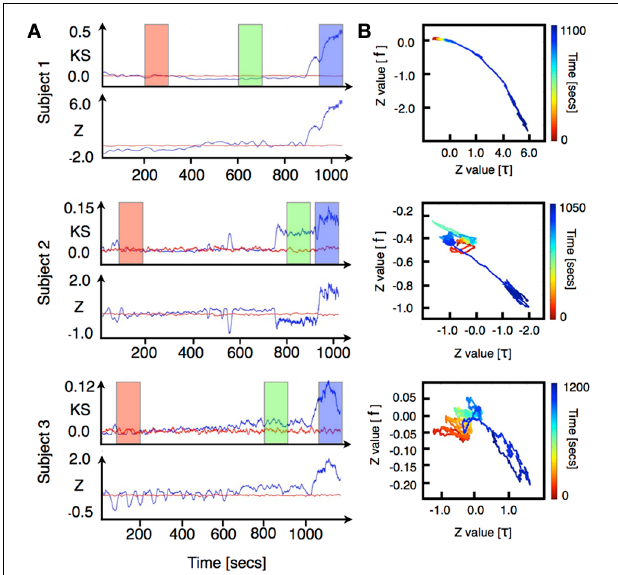
FIGURE 1 | ECoG signals were recorded from three human subjects as they were induced into general anesthesia. Data was locally fitted with VAR(1) models in windows of 200ms every 100ms (see methods). The linear stability of each model is compared to the awake state by means of two statistical tests. (A) top rows: Kolmogorov Smirnov test. For each model we plot the KS statistics of comparing the fitted distribution of eigenvalues against the awake state. (A) bottom rows: The distribution of time scales is compared using Wilcoxon test. Both quantities were averaged in time intervals of 10 s. The stability properties of locally fitted VAR(1) models change as the subjects undergo anesthesia. We defined three different segments (color rectangles) which were used for subsequent figures. (B) Changes in the frequency and stability of the eigenmodes. We compared the distributions of frequencies and time scales using a Wilcoxon test. In each figure, the vertical axis shows the z -value of comparing the frequency distributions whereas the horizontal axis shows the same test for the stability parameters distributions. The color code represents time elapsed since the beginning of the recording. In this representation all realizations yield qualitatively similar results: as the subjects are induced, the fitted frequencies shift to higher values at the same time they become more damped.